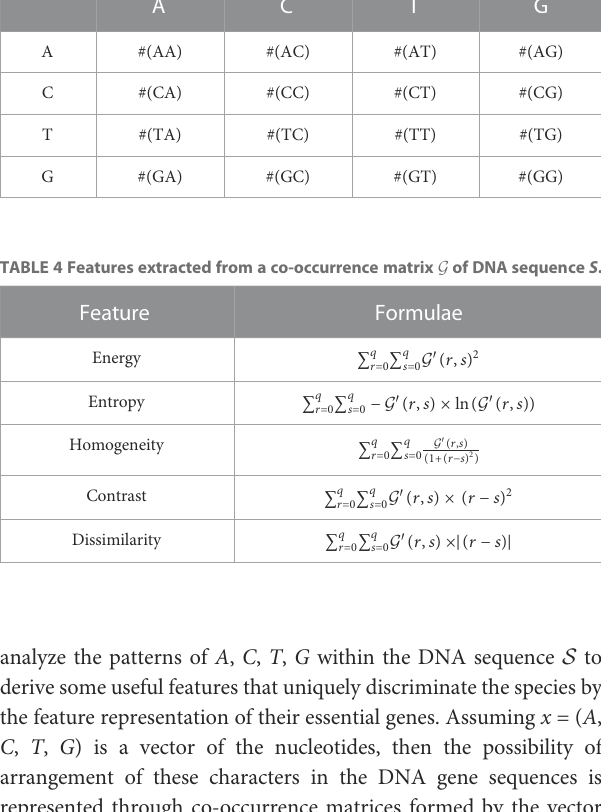
TABLE 1 List of species considered in the proposed technique.